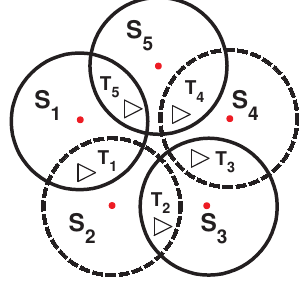
Figure 2. One disjoint cover set